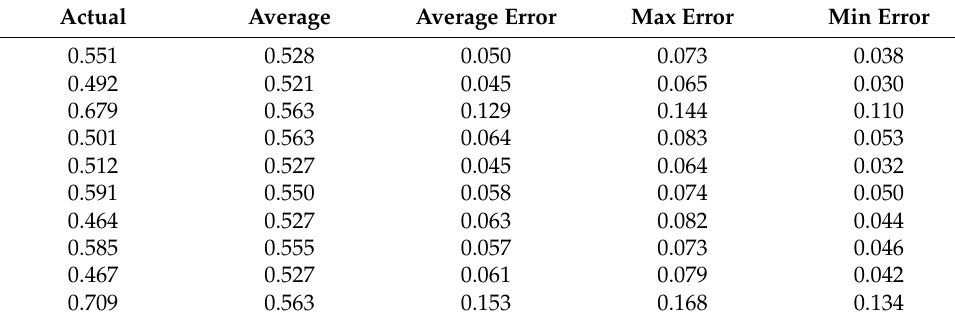
Table A63. Set 1, trials 41–50 data (single 0.5 PR